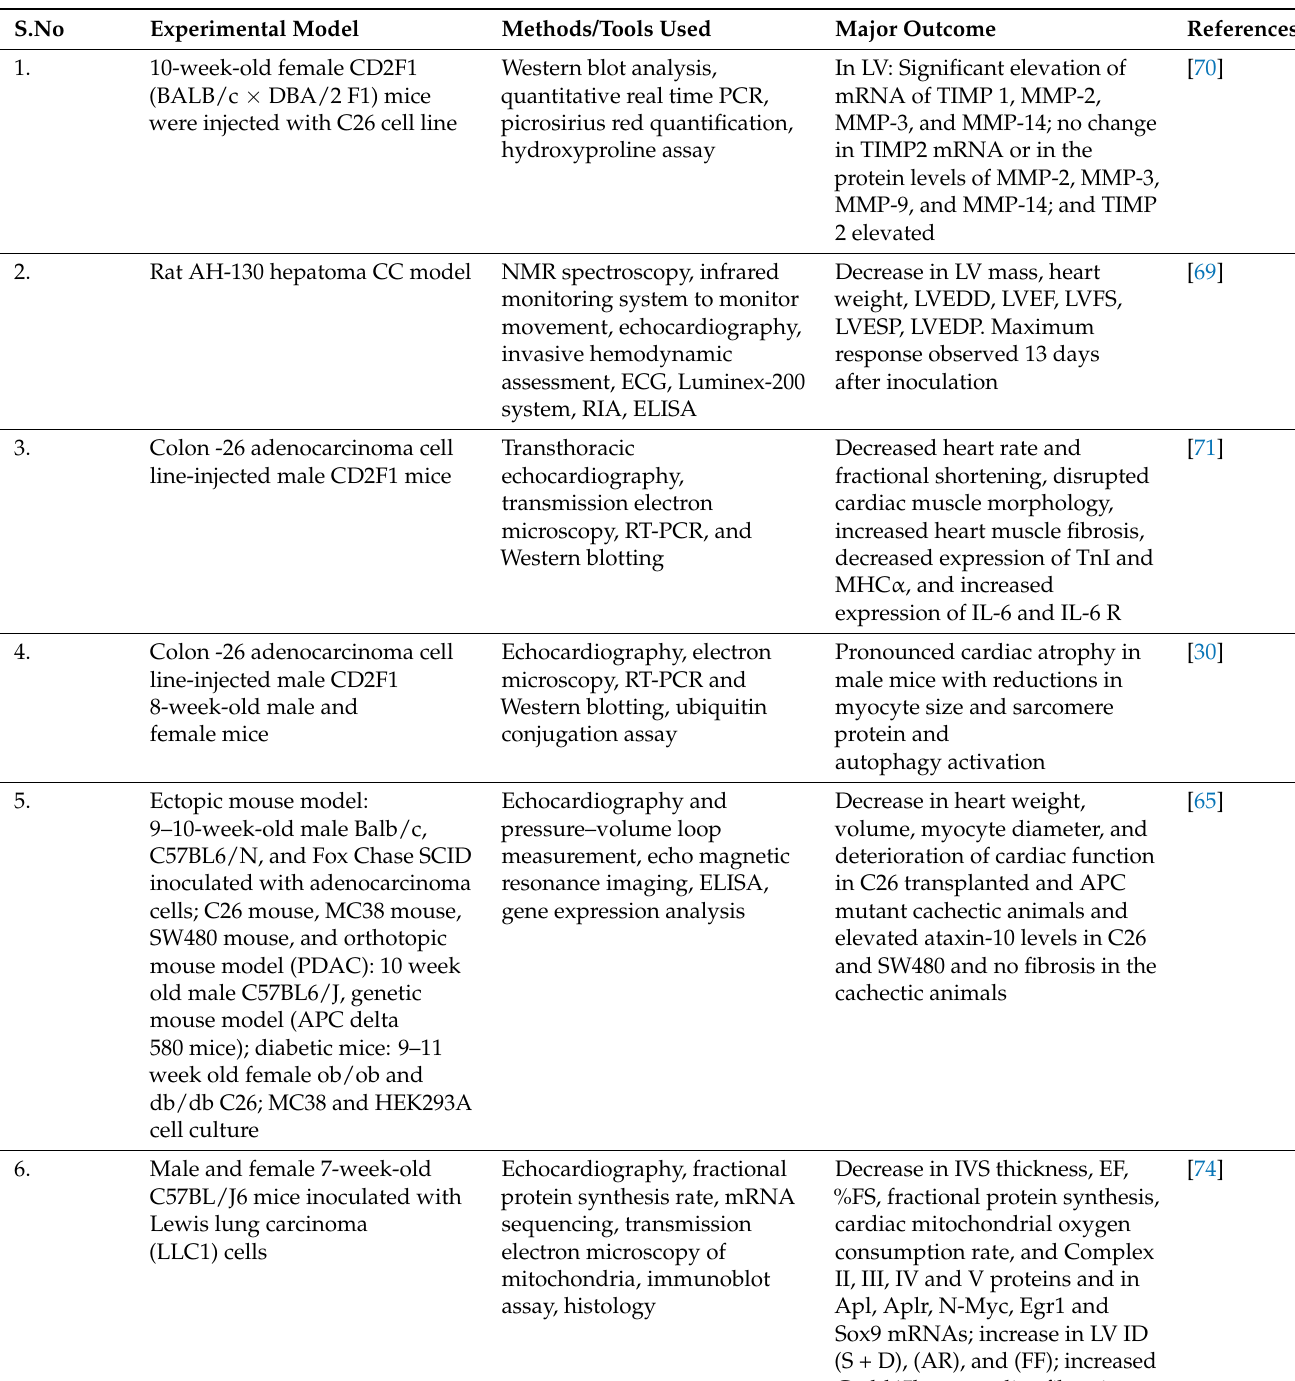
Table 1. Evidence from in vivo and in vitro experiments on cancer-induced cardiac